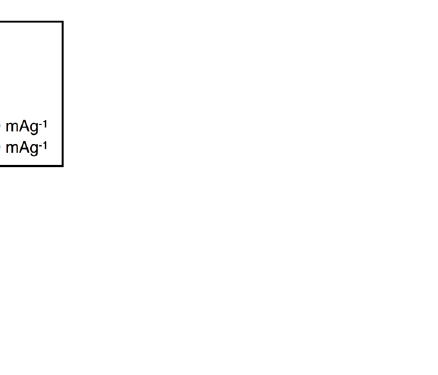
4 ScientiFic REPORTS | (2018) 8:579 | DOI:10.1038/s41598-017-19037-8